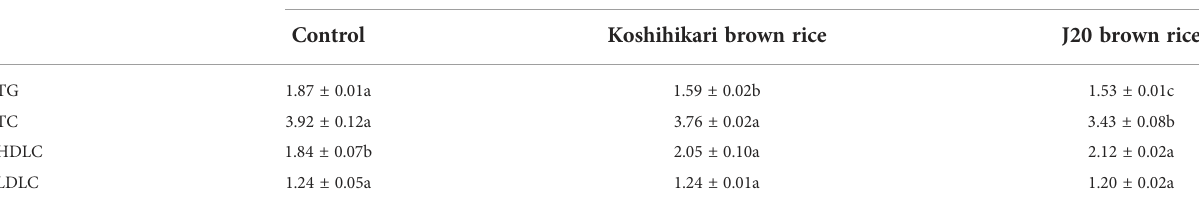
TABLE 9 Detection results of serum lipid related indexes in different groups of